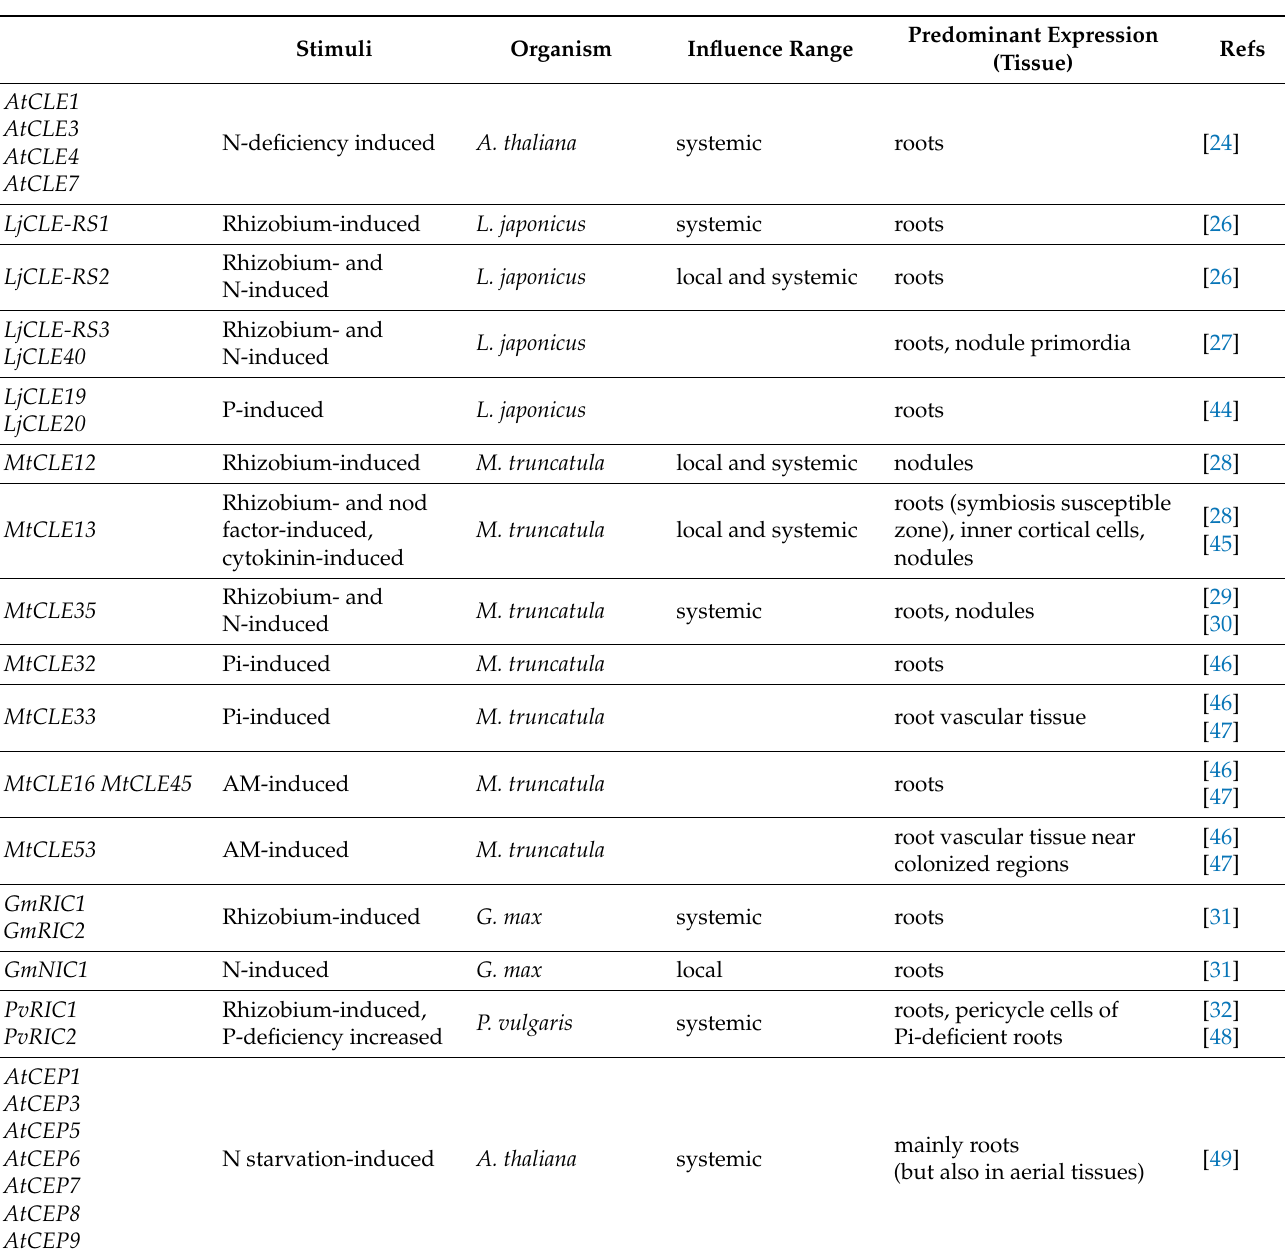
Table 1. List of selected CLE and CEP peptides responding to nitrogen (N), phosphorus (P) and microsymbionts (rhizobium and AM